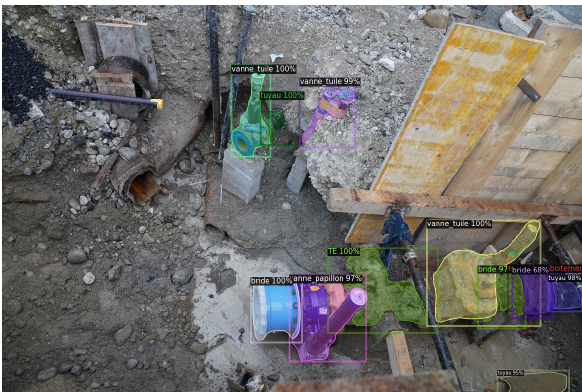
Figure 7: Raw image after inference.